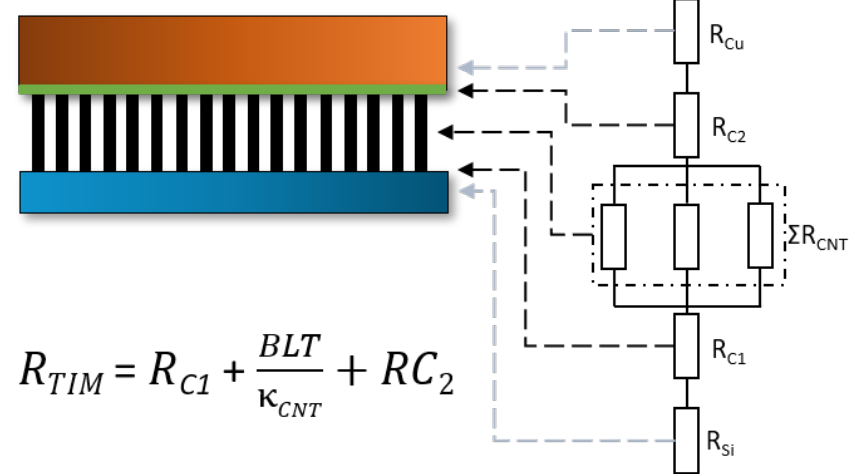
Figure 3. Simple schematic of the origin of the different thermal resistance contributions in the CNT array TIM. The black contributions were included in the thermal interface resistance results that were obtained from the laser flash experiment